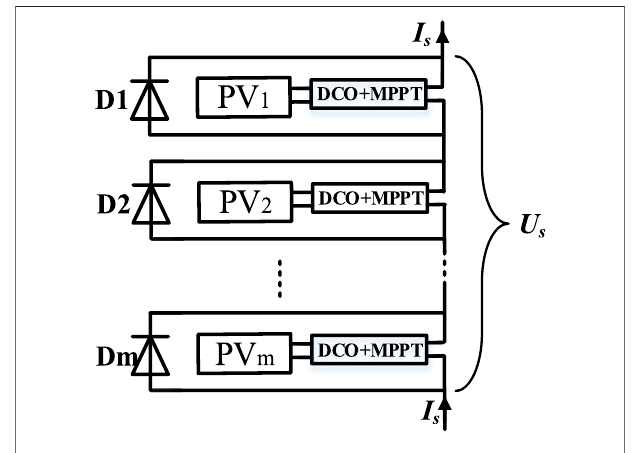
FIGURE 3 | PV string with panel-level